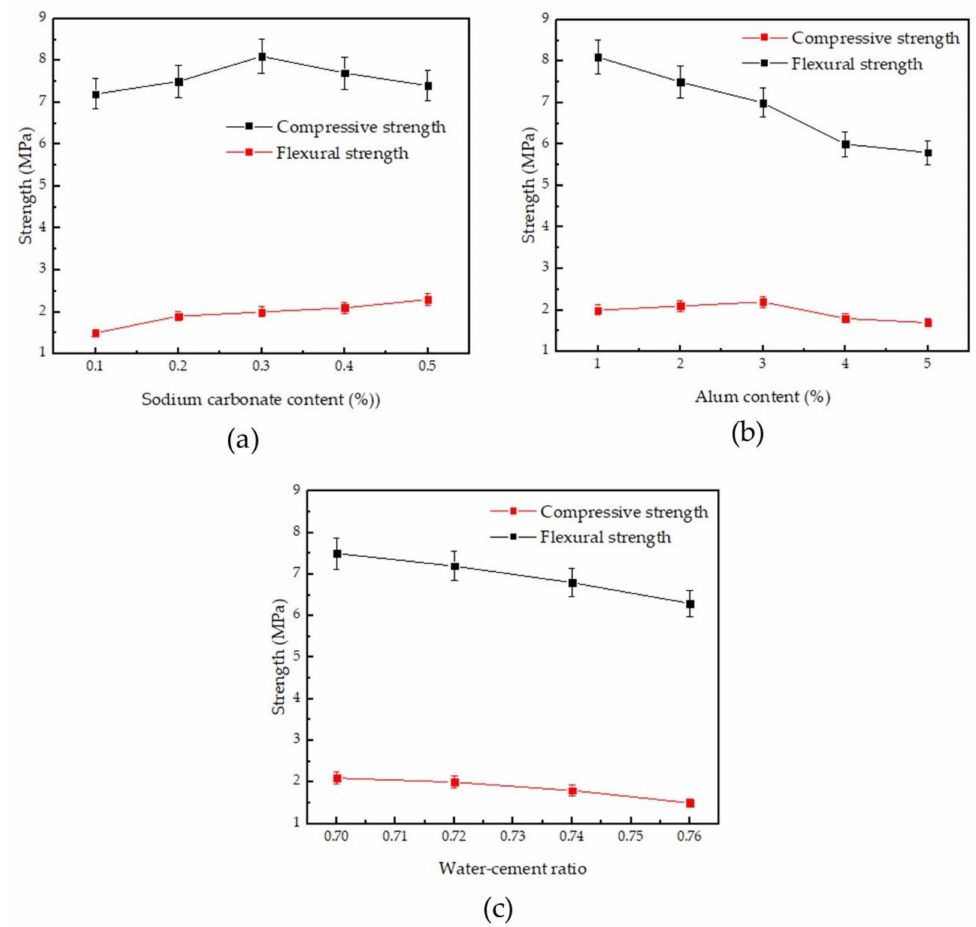
Figure 3. Effect of sodium carbonate and alum on compressive strength and flexural strength: ( a ) alum content is 1%, and sodium carbonate content changed; ( b ) sodium carbonate content is 0.3%, and alum content changed; and ( c ) sodium carbonate content is 0.3%, alum content is 2%, and water–cement ratio